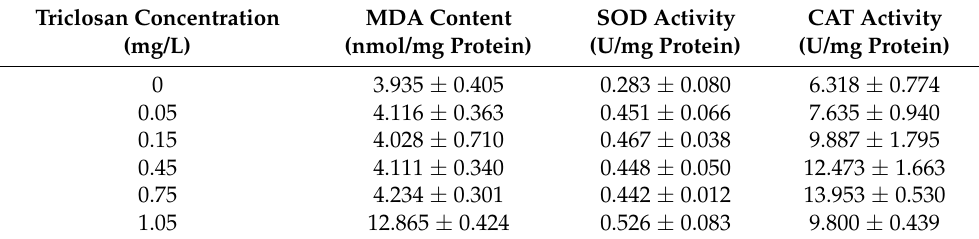
Table 1. Effects of varying concentrations of triclosan on MDA content, CAT and SOD activities of Chlorella vulgaris.